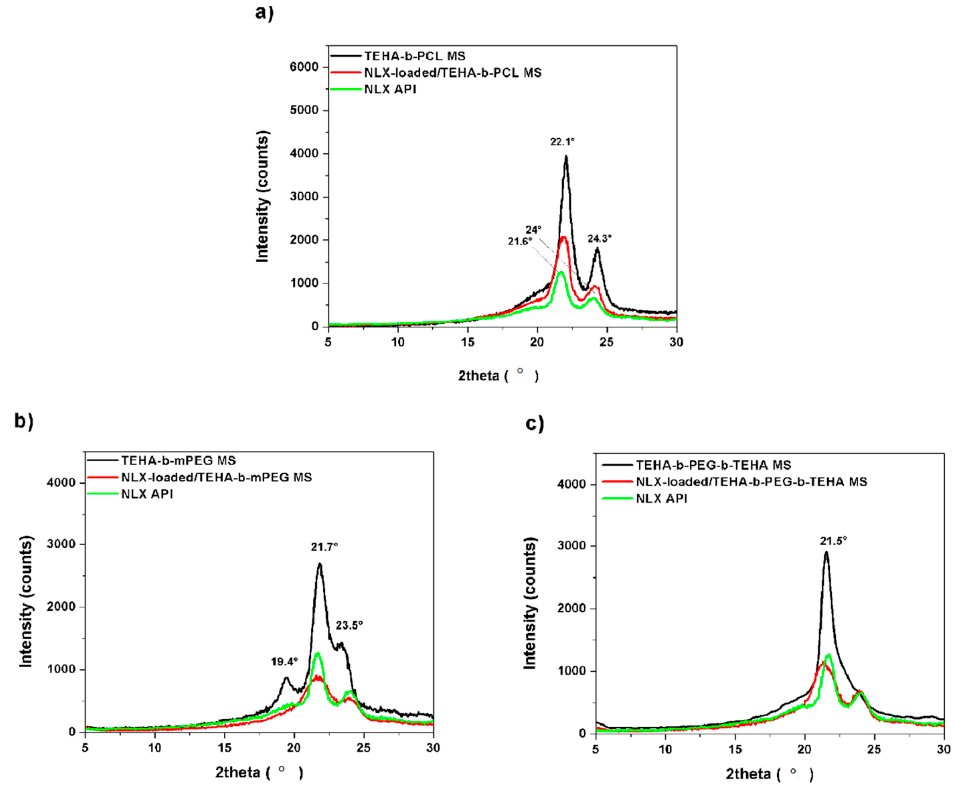
Figure 6. XRD patterns of NLX API in comparison with NLX-free and NLX-loaded microspheres